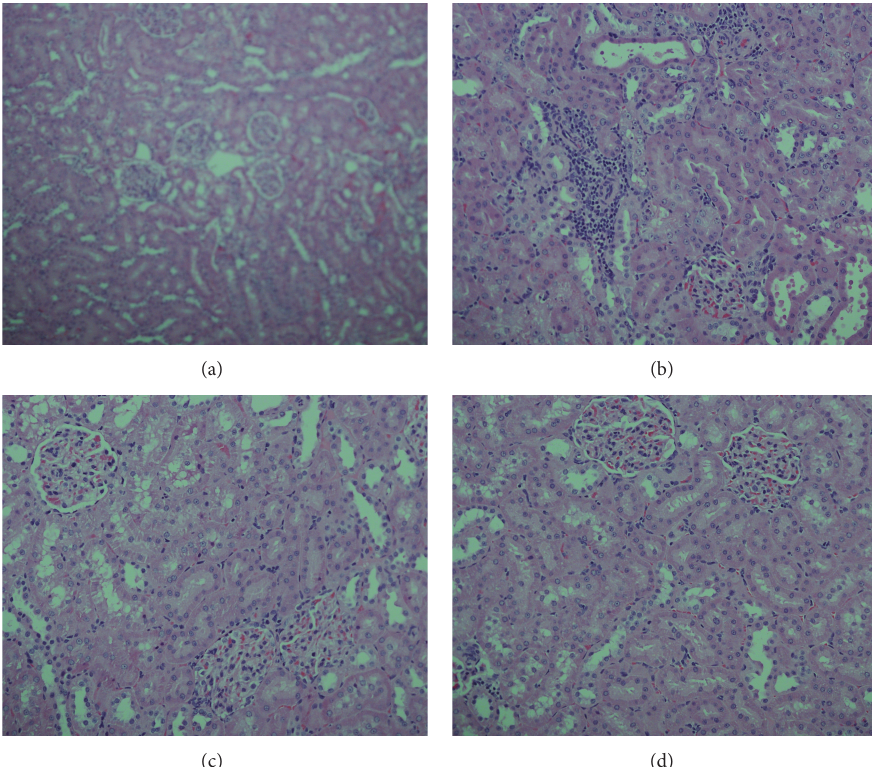
Figure 5: Representative photomicrographs of kidney sections from rats treated with BVEE and gentamicin (H&E staining). Light microscopic examination ( × 20 objective lens) of kidney tissue. (a) Normal kidney section; (b) effect of gentamicin on kidney tissue showing tubular degeneration, massive necrosis, and focal interstitial nephritis made up of lymphocytes and plasma cells, desquamation of renal tubule epithelium, and vacuolization; (c) effect of BVEE 250 mg/kg, pretreatment showing absence of interstitial nephritis and improvement degree of renal tubule changes; (d) effect of BVEE 500 mg/kg, pretreatment showing almost normal tubules, interstitial, and